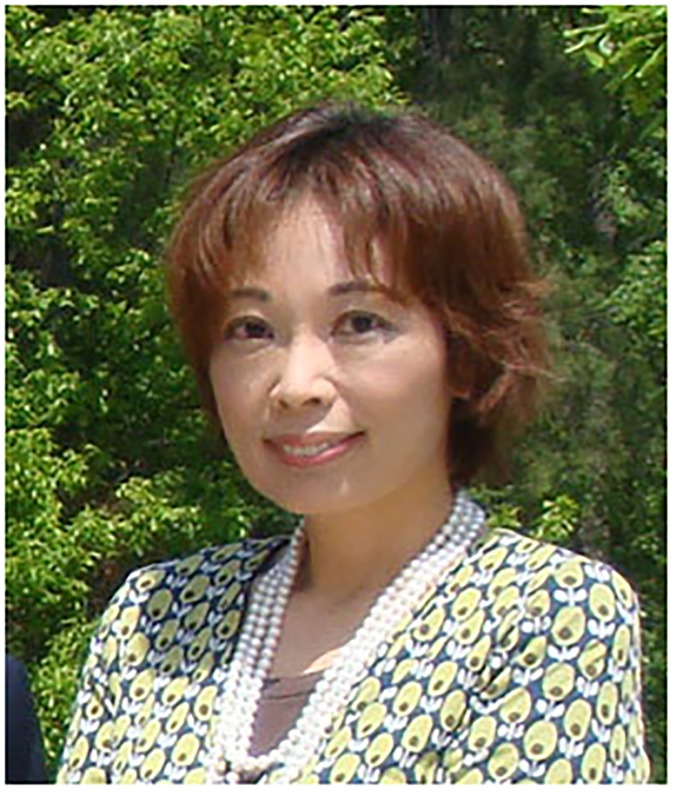
Mari L. Shinohara.